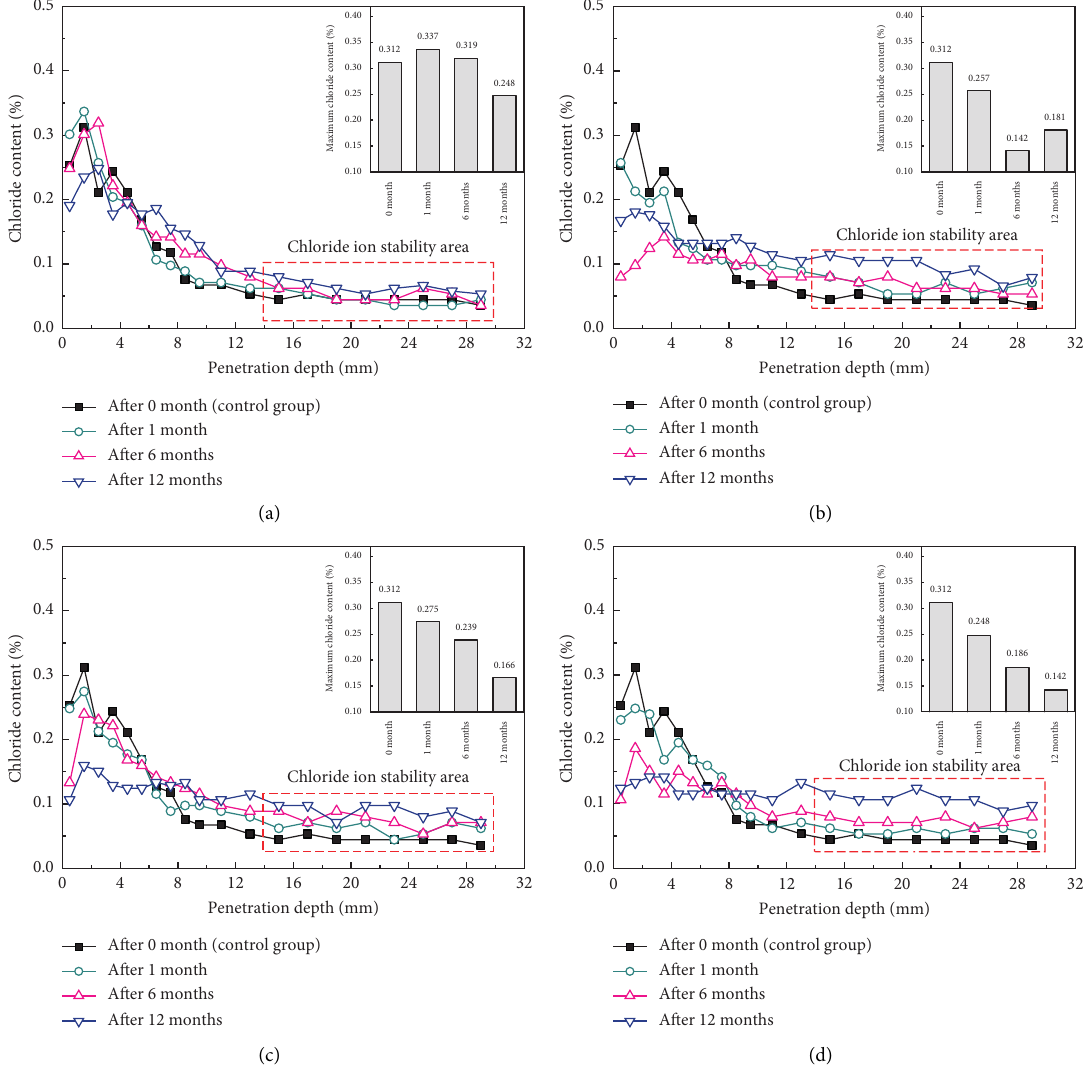
Figure 7: Chloride content curves for concrete subjected to various external RH values (w/c � 0.5). (a) RH � 50%, (b) RH � 75%, (c) RH � 80%, and (d) RH � 100%. Control group represents that the chloride content was immediately determined after chloride attack.